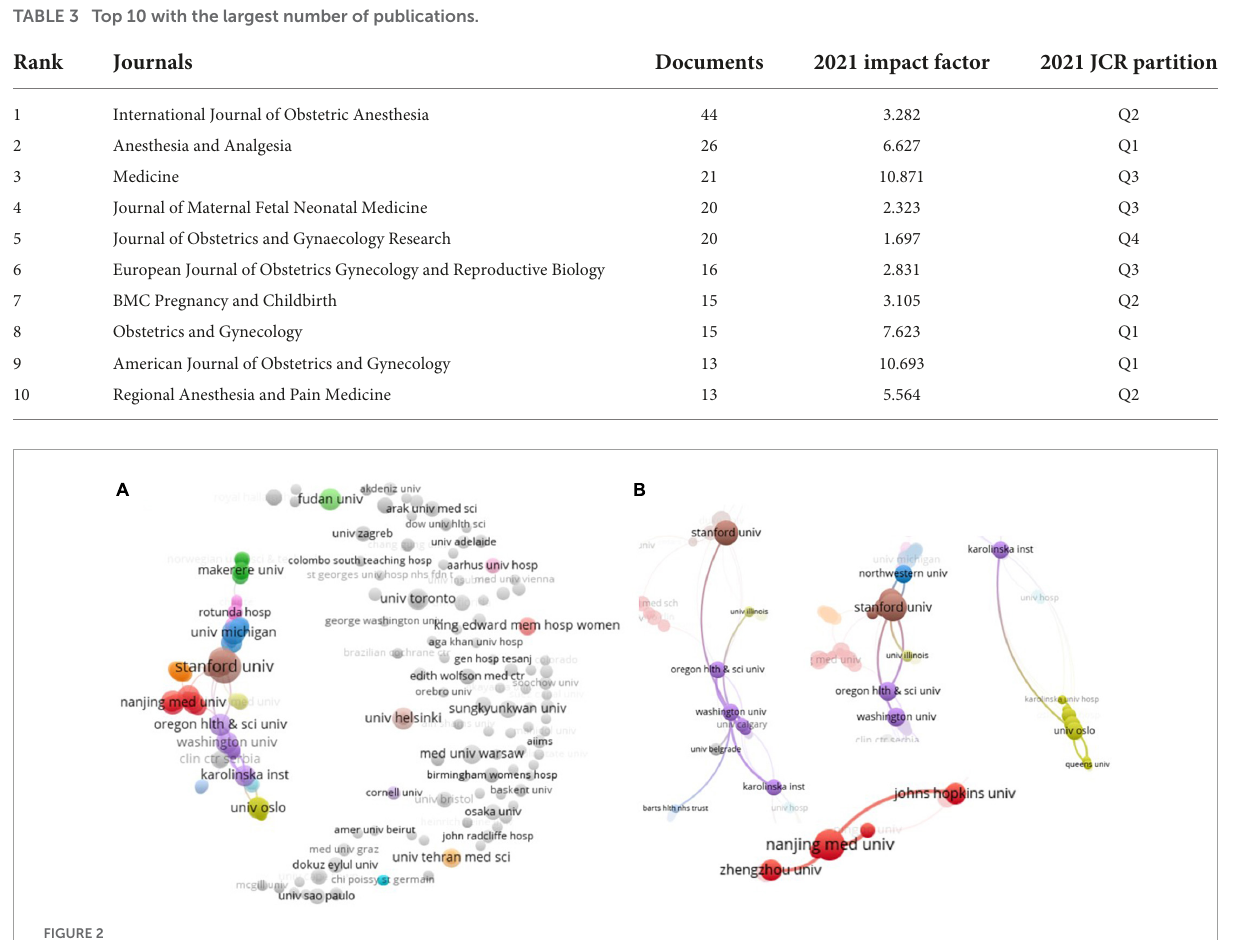
FIGURE2 Co-author analysis of organizations with network visualization. (A) The largest set of 308 valid items were interlinked. (B) Some partners of organizations were performed.